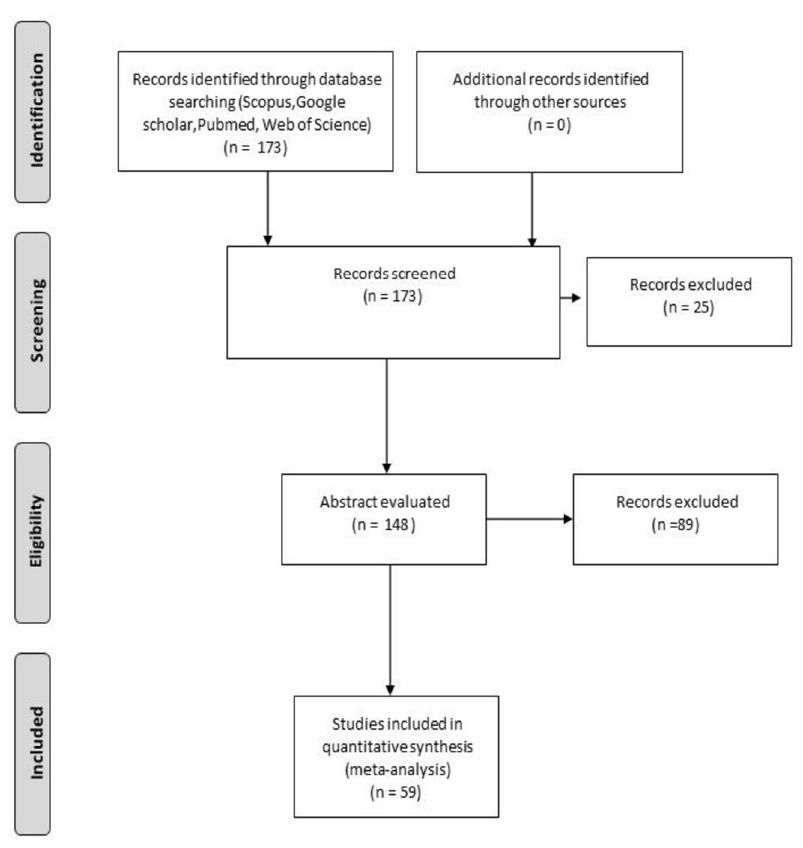
Figure 1. PRISMA flow diagram, showing the process of study selection.